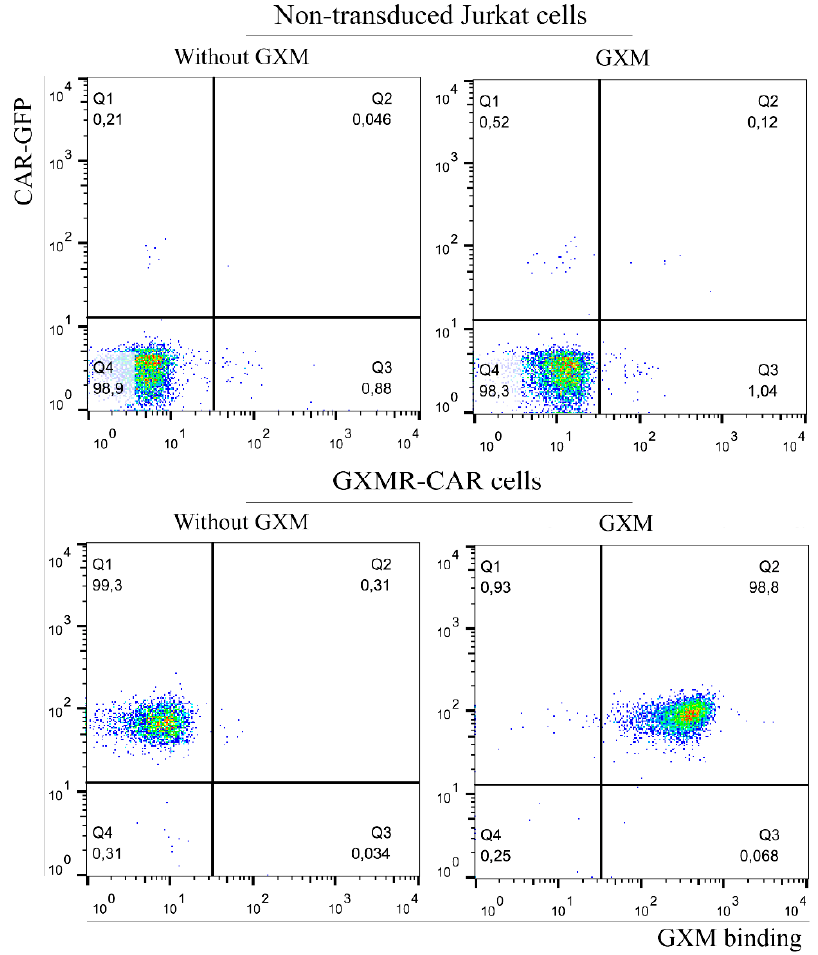
Figure 1. Interaction of GXMR-CAR cells with soluble GXM from C. gattii R265. A total of 5 × 10 ⁵ cells of GXMR-CAR and non-transduced Jurkat cells were incubated with soluble GXM (200 μ g/mL) obtained from C. gattii . The detection of cell surface GXM was performed after incubation with murine anti-GXM antibody, followed by biotin-labeled goat anti-mouse IgG and streptavidin- phycoerythrin. GFP-expressing GXMR-CAR cells are visualized on the y-axis, and GXM binding is observed on the x-axis by PE fluorophore after acquisition by flow cytometry. 2.7. Interaction of GXMR-CAR + Cells and Cryptococcus spp. by Fluorescence